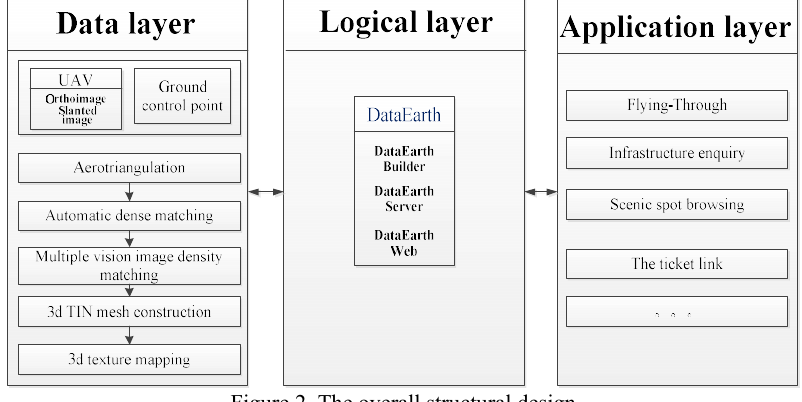
Figure 2. The overall structural